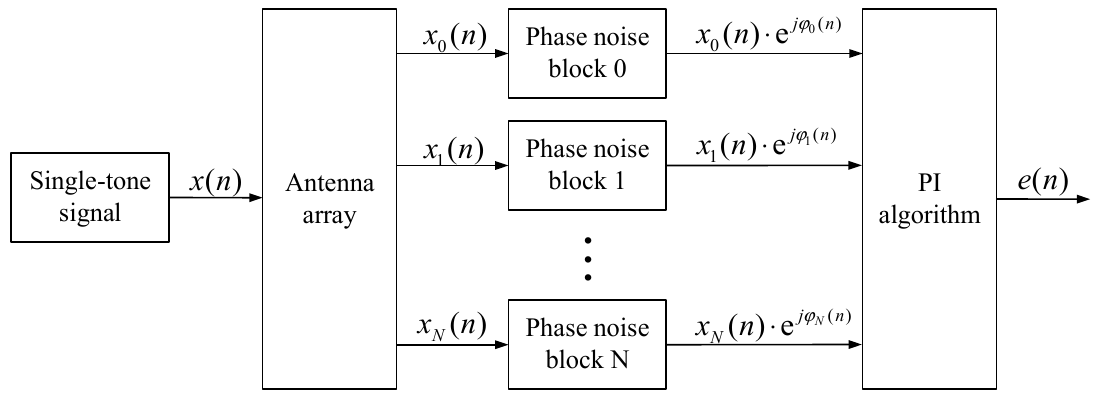
Figure 3. Simulation method.